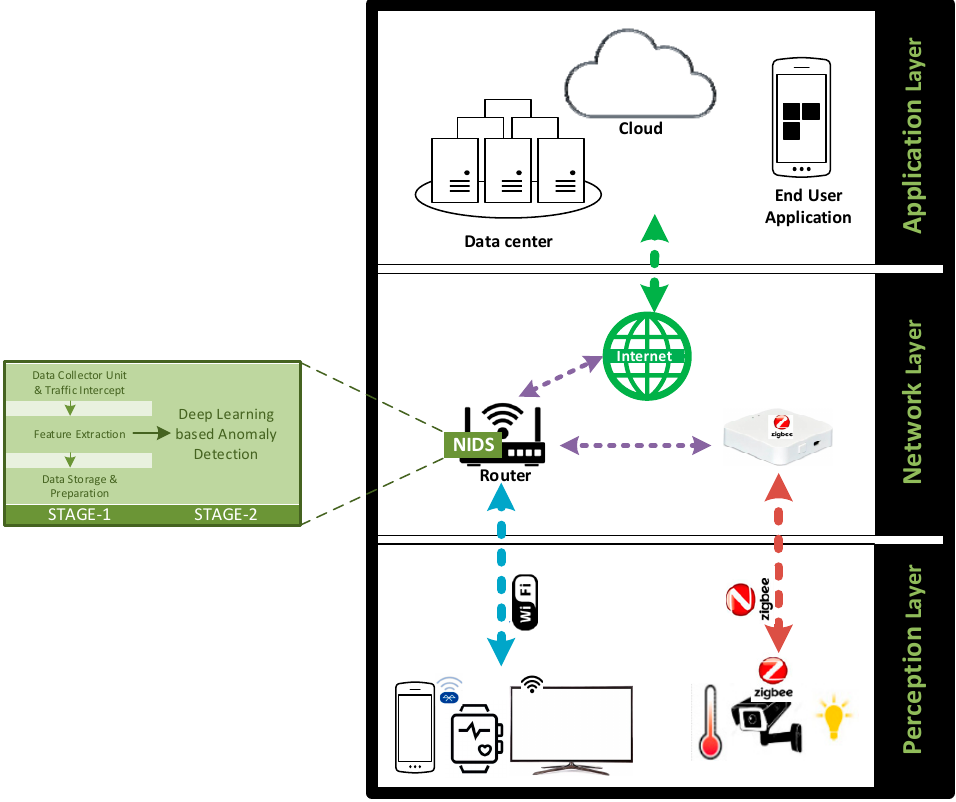
Figure 2. A three-layered IoT architecture.